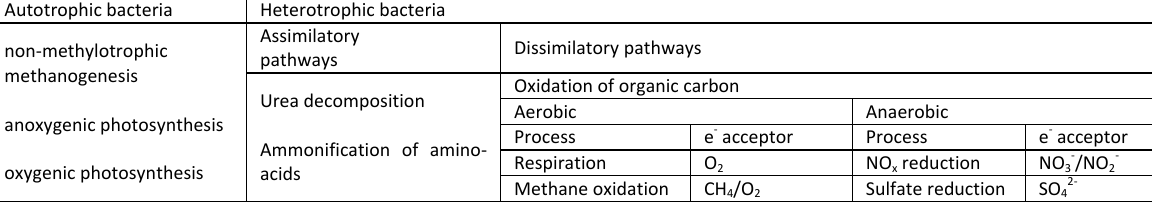
Table 1. Different metabolic pathways of bacterial calcium carbonate precipitation [8]. Autotrophic